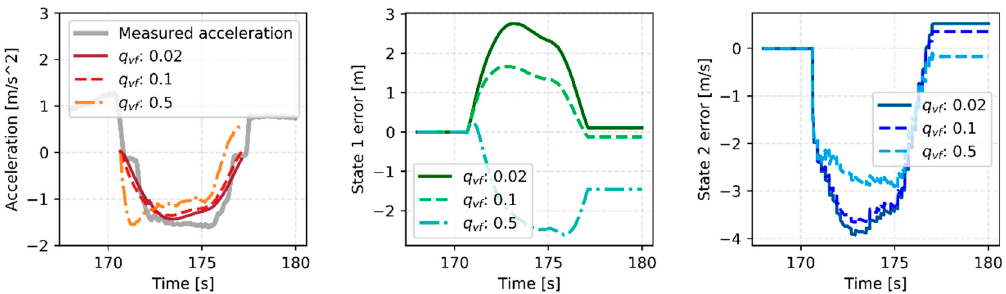
Figure 12. Deceleration planning results according to q vf weight value ( N : 15, q df :